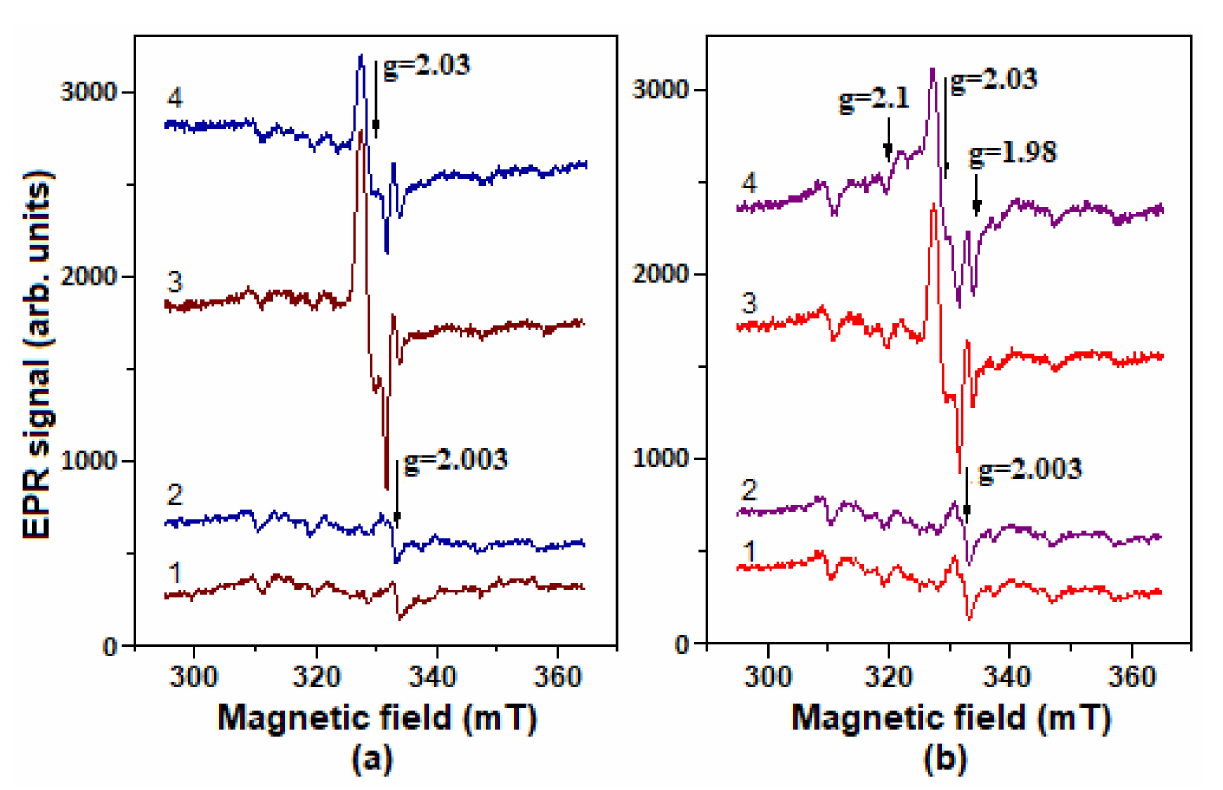
Figure 9. Low-temperature EPR spectra of E. coli cells: C Lb − ( a ) and C Lb++ ( b ). 1—untreated bacteria; 2—bacteria after incubation with t -BOOH; 3—after incubation with GSNO; 4—after incubation with GSNO + t -BOOH. The registration was carried out at − 170 ◦